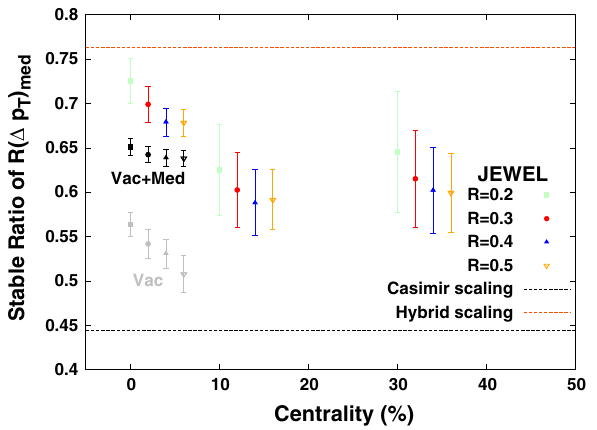
Fig. 7 The asymptotic scaling extracted via fitting R (Δ p T ) med in p Z We plot the data points in sets of 4 (0–10 %, 10–20% and 30–50%). For each centrality bin, the points of different jet radius have an offset in centrality for a better visualisation of the results. Black points labeled medium correspond to the extraction from R (Δ p T ) v ac + med and grey points labeled vacuum were extracted from R (Δ p T ) v ac